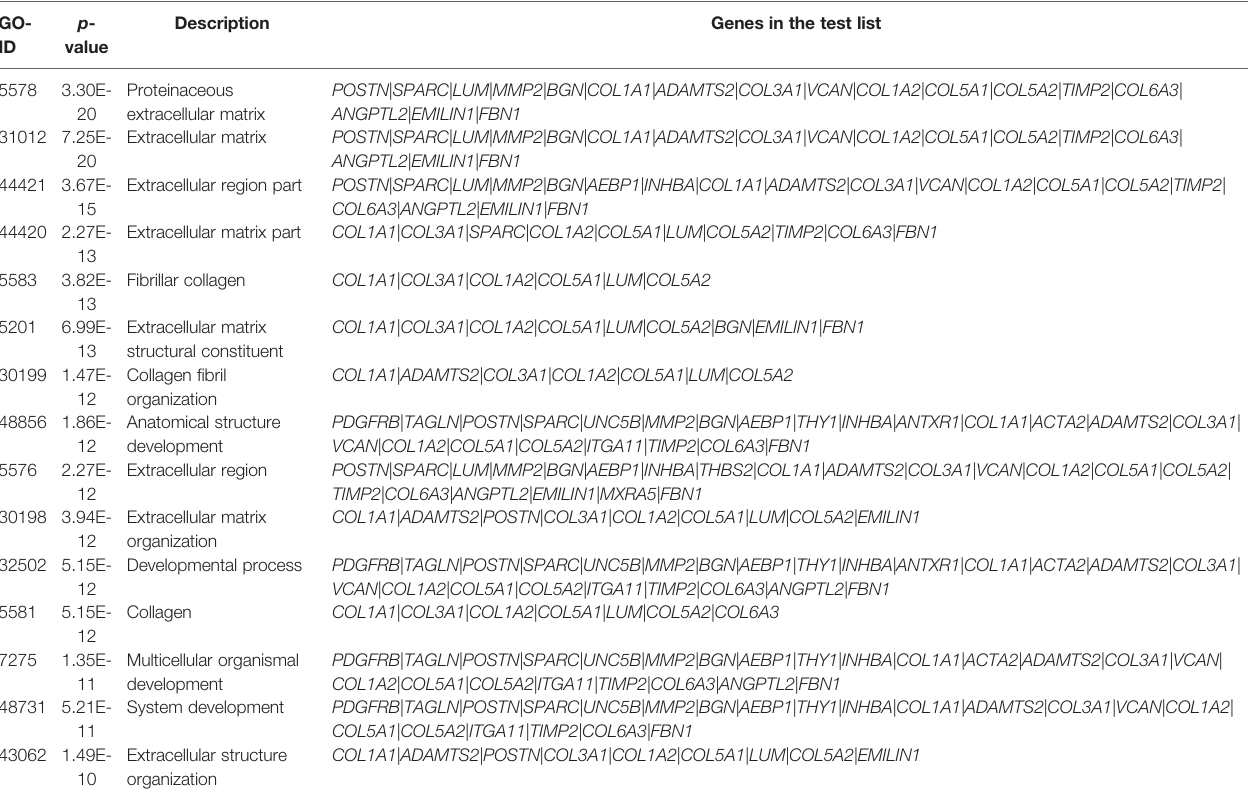
TABLE 3 | The top 15 GO items of genes in the pink